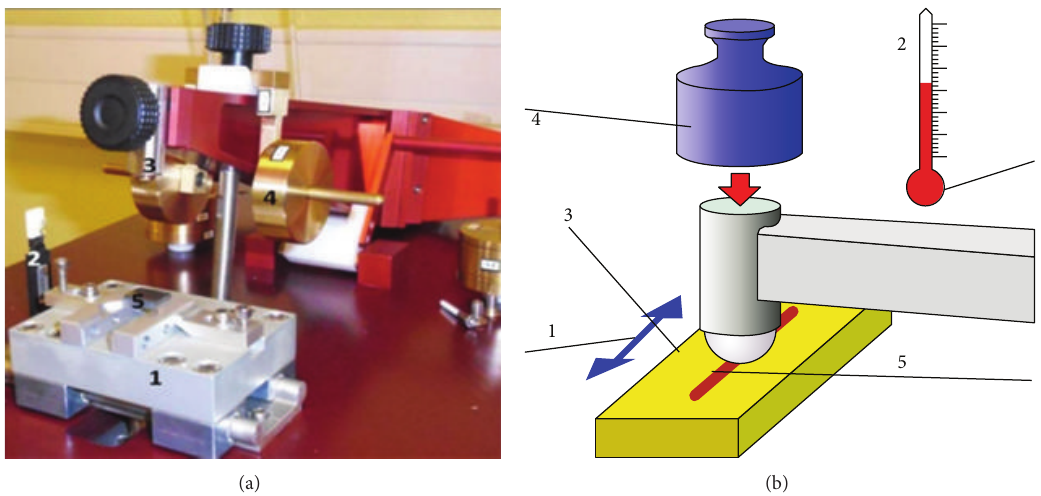
Figure 2: (a) Photography of ball-on-disc contact and tribotester system. (1) Table in alternative movement. (2) A sensor to measure heat and humidity. (3) Ball 100Cr6 steel. (4) Load applied 𝐹 . (5) Sample.